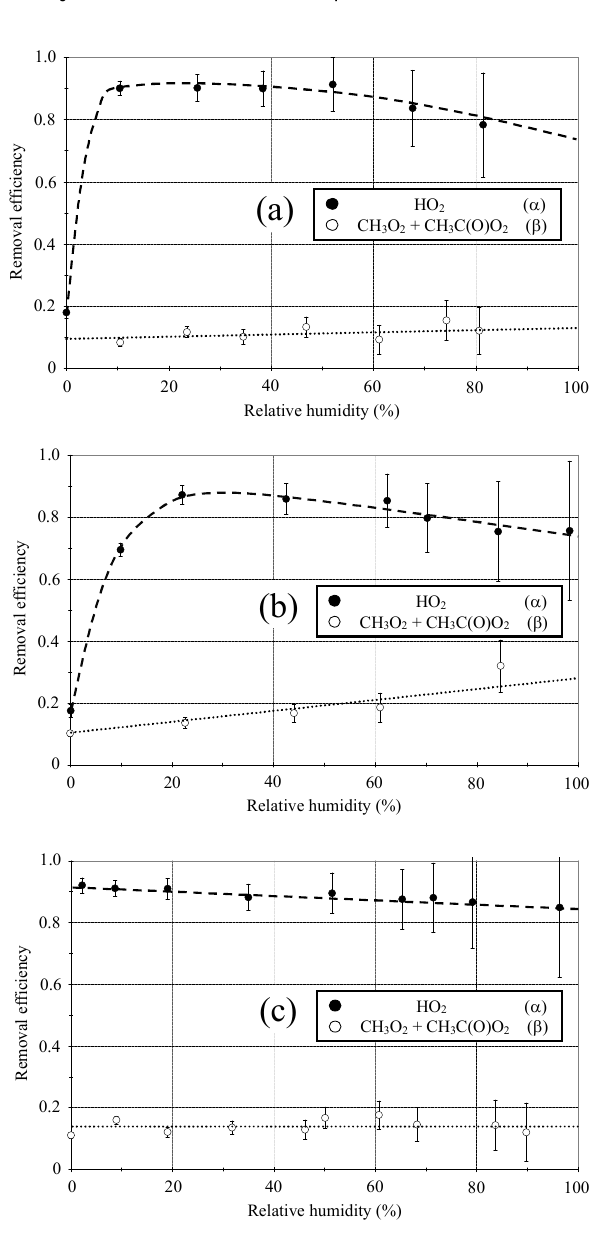
Fig. 3. Results of the removal efficiency α (HO 2 ) and β (CH 3 O 2 +CH 3 C(O)O 2 ) as a function of relative humidity using (a) PFA, (b) PTFE and (c) glass as the material in the removal cell.